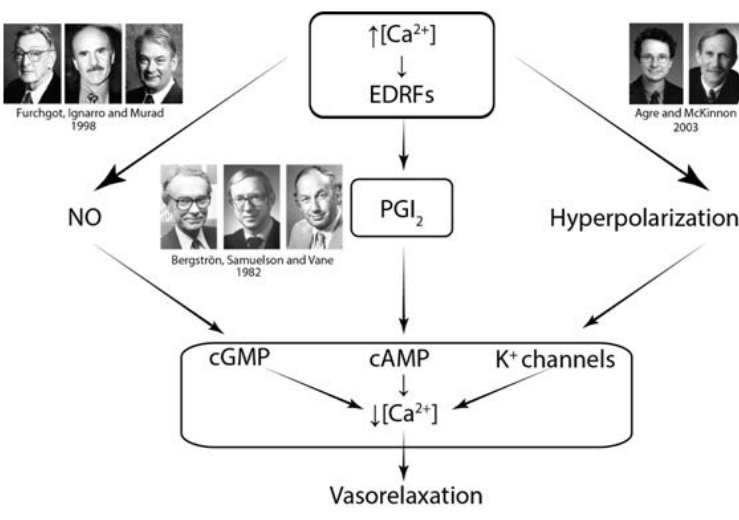
Fig. 2 - The three mechanisms of vasodilatation. cAMP=3’,5’-cyclic adenosine monophosphate; cGMP=cyclic guanosine monophosphate; EDRFs=endothelium- derived relaxing factors; NO=nitric oxide;